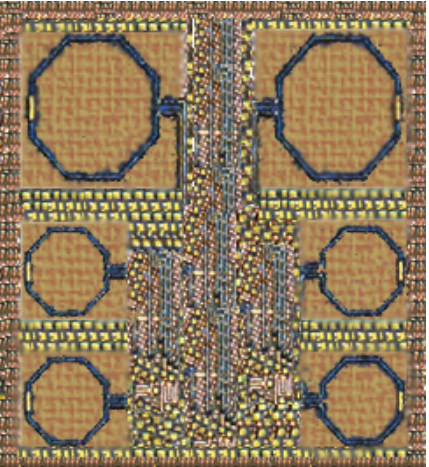
Figure 15. Microphotography of the up-conversion mixer.